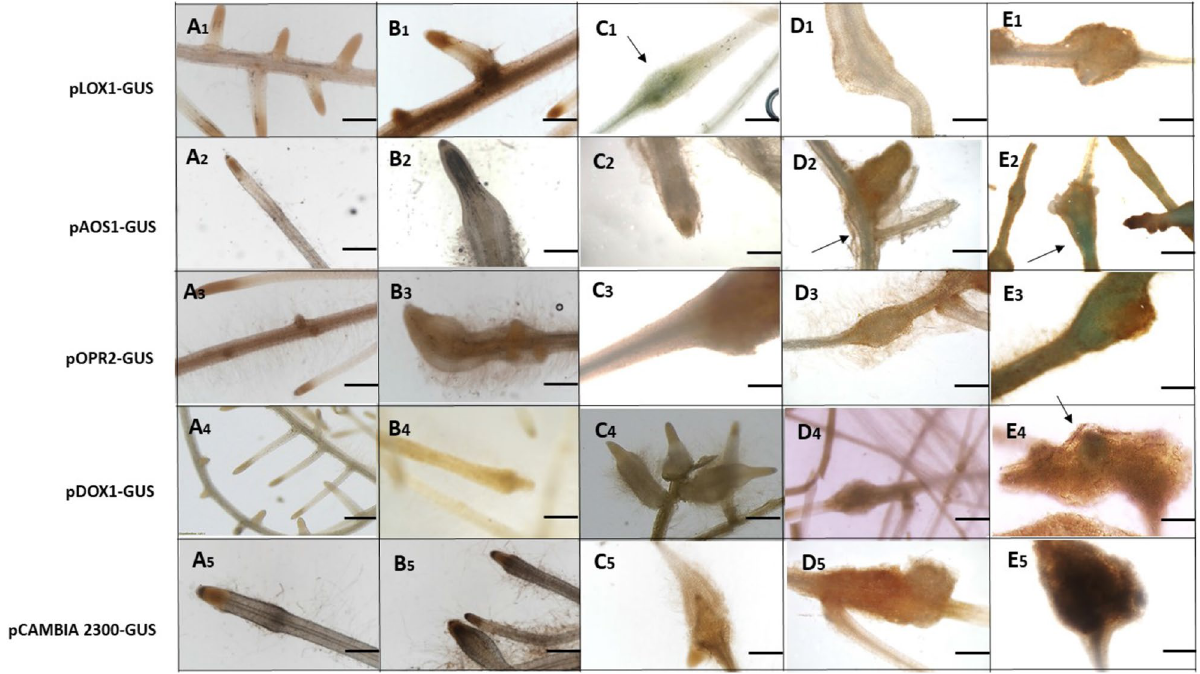
Figure 2. Microscopic analysis of GUS expression patterns in root-knot nematode-inoculated tomato roots harboring LOX1.2, AOS1, OPR2 and, α-DOX1 promoter: GUS fusion constructs. ( A1–E1 ) Micrographs of LOX1.2 –GUS reporter line. ( A1 ) Noninoculated root harboring the LOX1.2 :GUS fusion construct exhibits no GUS signal related to root tip or elongation zone. ( B1 ) Roots 2 days after inoculation (DAI). ( C1 ) Inoculated roots 5 DAI. ( D1 ) Developing galls 15 DAI. ( E1 ) Mature galls 28 DAI. ( A2–E2 ) Micrographs of AOS1–GUS reporter line. ( A2 ) Noninoculated root harboring the AOS1 :GUS fusion construct exhibits no GUS signal related to root tip or elongation zone. ( B2 ) Roots 2 DAI. ( C2 ) Inoculated roots 5 DAI. ( D2 ) Developing galls 15 DAI. ( E2 ) Mature galls 28 DAI. ( A3–E3 ) Micrographs of OPR2–GUS reporter line. ( A3 ) Noninoculated root harboring the OPR2 :GUS fusion construct exhibits no GUS signal related to root tip or elongation zone. ( B3 ) Roots 2 DAI. ( C3 ) Inoculated roots 5 DAI. ( D3 ) Developing galls 15 DAI. ( E3 ) Mature galls 28 DAI. A5–E5, Micrographs of αDOX1–GUS reporter line. ( A4 ) Noninoculated root harboring the αDOX1:GUS fusion construct exhibits no GUS signal related to root growth. ( B4 ) Roots 2 DAI. ( C4 ) Inoculated roots 5 DAI. ( D4 ) Developing galls 15 DAI. ( E4 ) Mature galls 28 DAI. ( A5–E5 ) Micrographs of pCAMBIA2300–GUS reporter line; empty pCAMBIA2300 vector fused to GUS reporter served as a control. ( A5 ) Noninoculated root harboring the pCAMBIA2300 : GUS fusion construct exhibits no GUS signal related to root tip or elongation zone. ( B5 ) Roots 2 DAI. C5 Inoculated roots 5 DAI. ( D5 ) Developing galls 15 DAI. ( E5 ) Mature galls 28 DAI. Arrows indicate GUS staining (C1, D2, E2, E3, D4 and E4): Micrographs viewed under a light microscope. Bright-field image of roots and galls photographed through a stereomicroscope. Bars: A1–A5, B1, B4, B5,